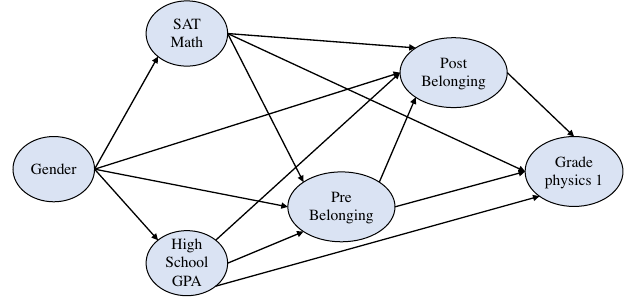
FIG. 1. Schematic representation of the path analysis of the model and how sense of belonging mediates the relation between gender and grade in the physics 1 course for bioscience majors in which women are not underrepresented. From left to right, all possible paths were considered (including the one from gender to grade in physics 1), however, only some of the paths are shown here for